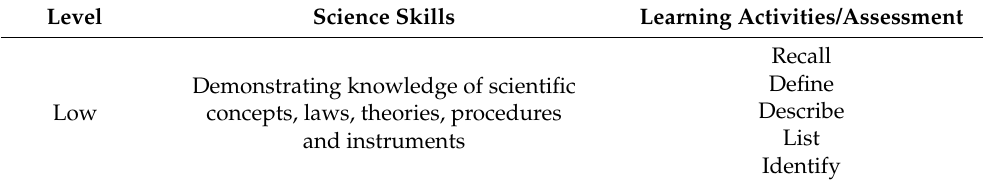
Table 2. Thinking skills in scientific learning activities.